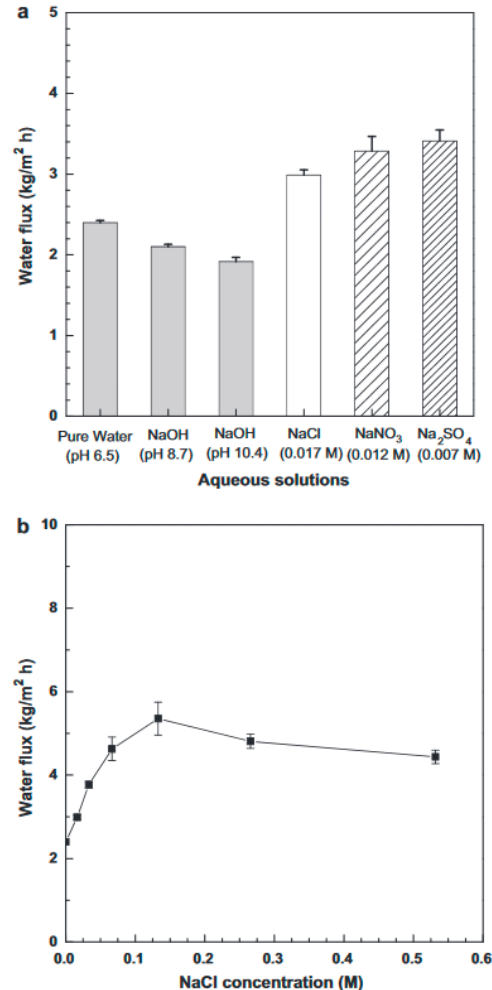
Figure 14. Pervaporative fluxes of NaA zeolite membrane with ( a ) pure water, NaOH (pH 8.7 and 10.4), 0.017 M NaCl, 0.012 M NaNO3 and 0.007 M Na 2 SO 4 solutions and with ( b ) various NaCl solutions [266]. Reproduced with permission from [266].